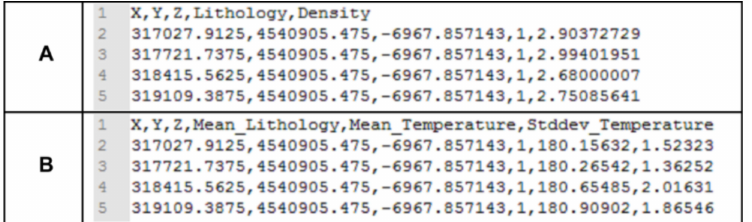
Figure 3. Internal structure of the data files of the voxel-based geological ( A ) and thermal ( B ) models that the 3DHIP-Calculator needs to be